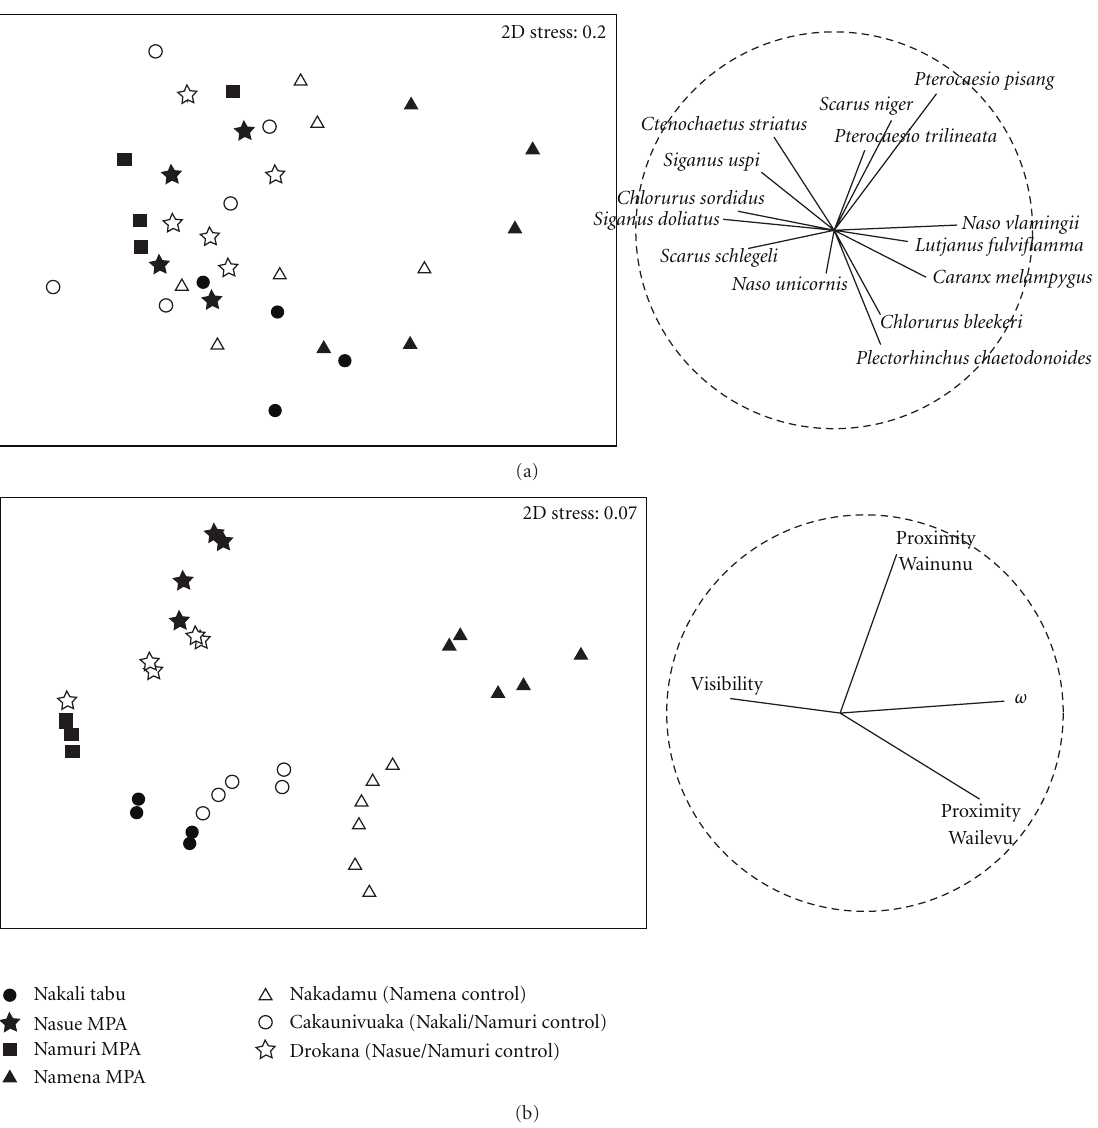
Figure 3: MDS plots showing distances between sites for (a) mean fish species biomass, coupled with vector trajectories for fish species that best explained variation among sites; and (b) potential fishing pressure, coupled with vector trajectories for all fishing pressure surrogates. Dark circles = Nakali tabu; open circles = Nakali/Namuri control (Cakaunivuaka reef); dark stars = Nasue MPA; open stars = Nasue/Namuri control (Drokana reef); dark square = Namuri MPA; dark triangle = Namena MPA; open triangle = Namena control (Nakadamu